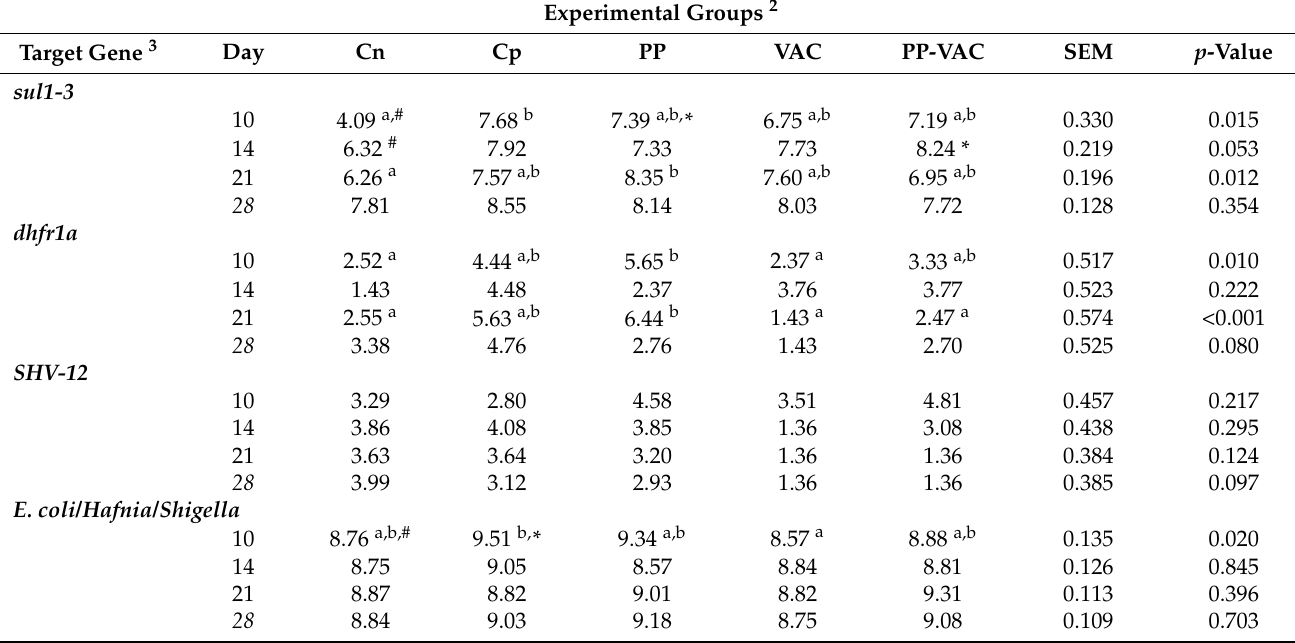
Table 4. Impact of parent stock vaccination and dietary pre-and probiotic combination on gene copy numbers (log 10 ) 1 of antibiotic resistance genes and bacterial group Escherichia coli / Hafnia / Shigella in excreta samples of growing Ross 308 broilers challenged with the multi-drug-resistant E. coli O1/O18 strain on day eight of